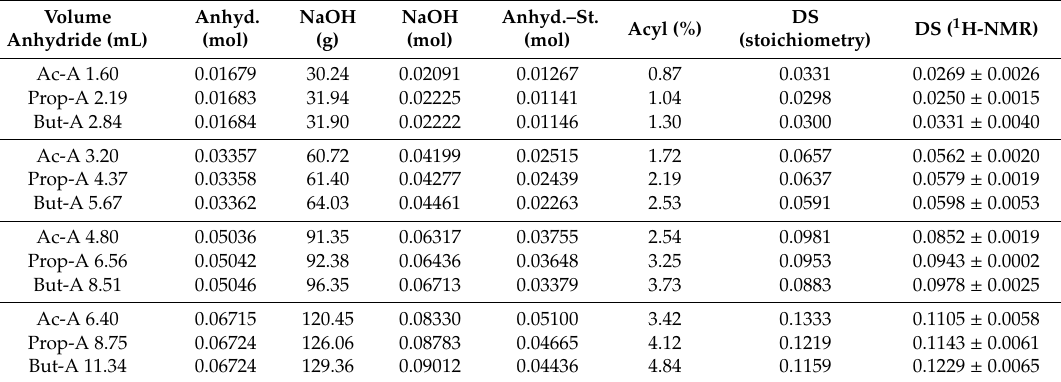
Table 3. Reaction, product parameters and DS obtained from stoichiometry and 1 H-NMR analysis of acetylated, propionylated, and butyrylated quinoa